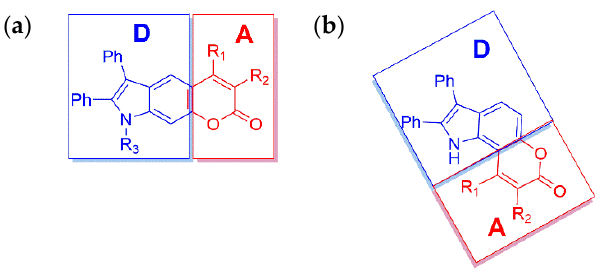
Figure 6. Donor-acceptor model of pyranoindoles 7 , 9 ( a ), and 8 ( b ).